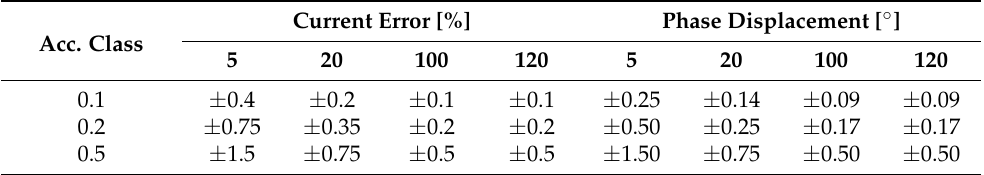
Table 1. Accuracy classes of measuring inductive CTs in accordance with the standard IEC 61869-2. Acc.